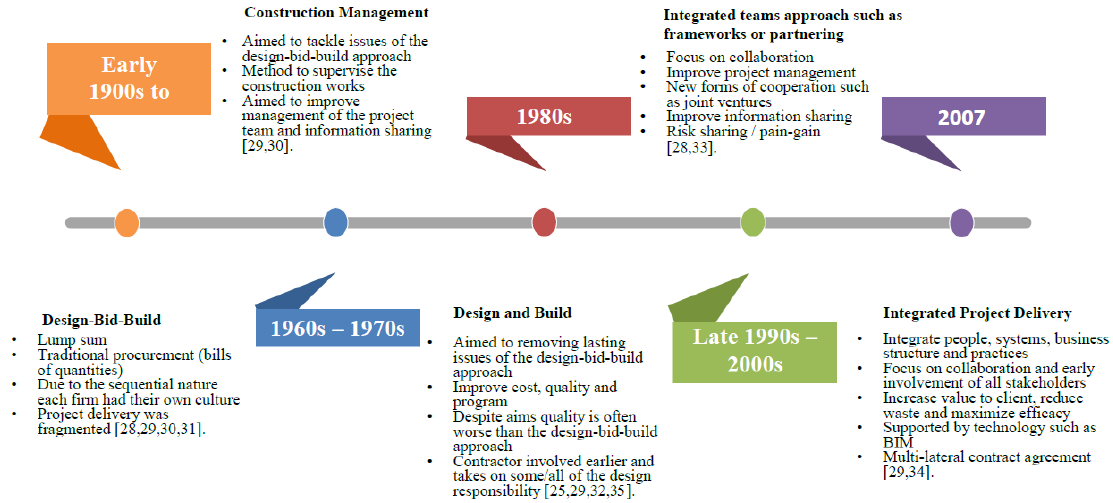
Figure 1. Timeline showing the evolution of procurement in the construction industry